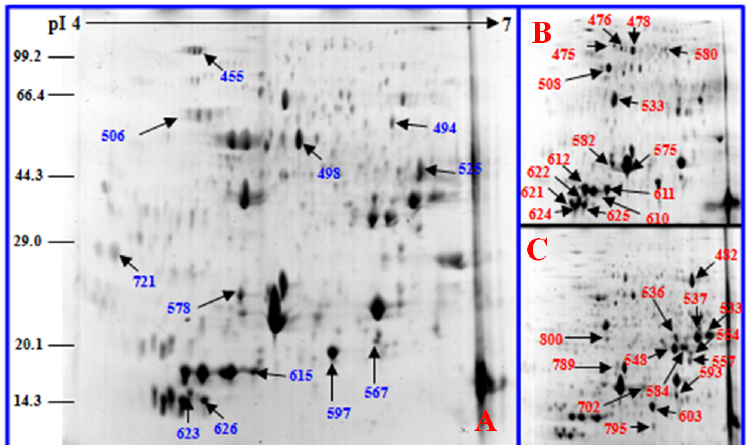
Figure 9. Coomassie Brilliant Blue (CBB)-stained two-dimensional electrophoresis gels of proteins from Robinia pseudoacacia diploid (2×) leaves. Proteins were separated on a 13 cm IPG strip (pH 4–7 linear gradient) using isoelectric focusing, followed by sodium dodecyl sulfate polyacrylamide gel electrophoresis on a 12.5% gel. ( A ) 1-day NaCl-treated leaves; ( B ) 5-day NaCl-treated leaves; ( C ) 10-day NaCl-treated leaves. Blue and red numbers indicate proteins that increased and decreased between control and stressed samples, respectively. The proteins are listed in Table